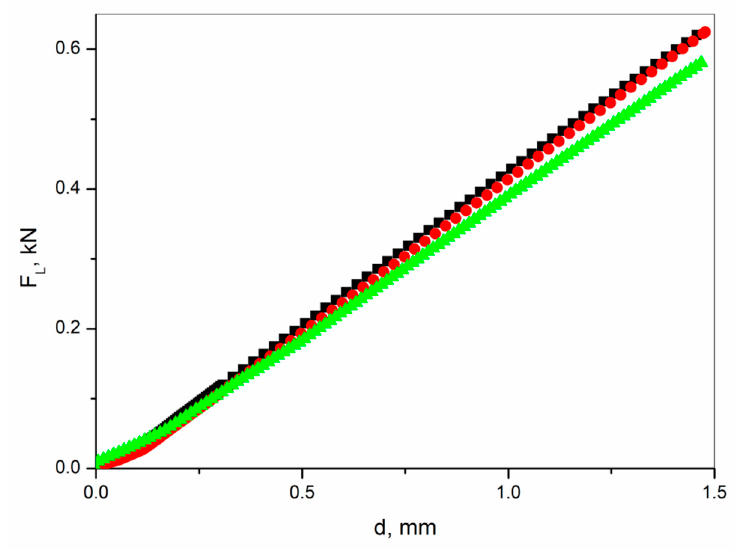
Figure 6. Load force vs. deflection curves recorded for the FRP laminate without an active layer ( ■ ) and with an active layer containing integrated sensor-area made of epoxy resin with 20% ( ● ) and 40% ( ▲ ) weight concentration of SbSI nanowires.